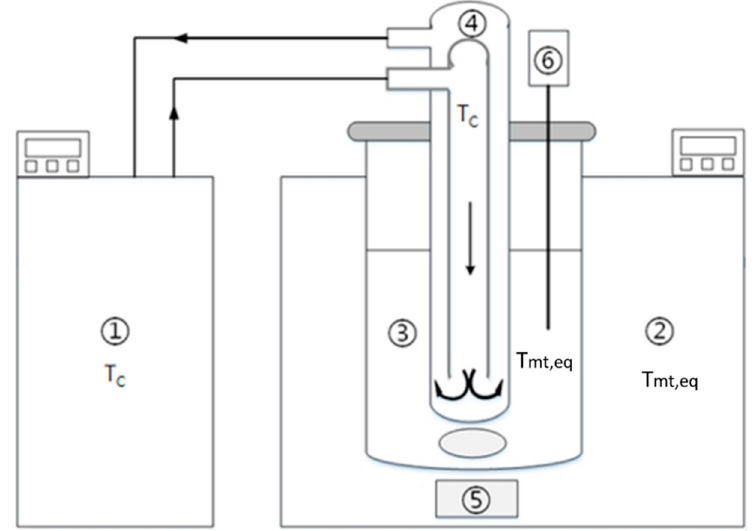
Figure 1. Schematic diagram of the experimental apparatus: (1) water bath for the cooling finger, (2) water bath for the crystallizer, (3) melt, (4) cooling finger with water inlet and outlet, (5) magnetic stirrer and (6) temperature probe.